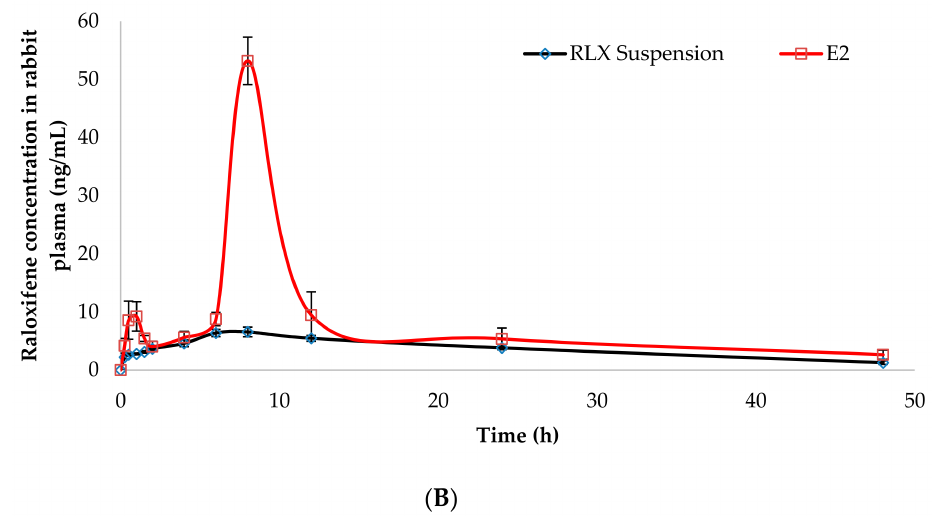
Figure 6. ( A ) Ex vivo drug permeation from RLX-loaded NFs formula (E2), in comparison to RLX aqueous dispersion, in phosphate buffer saline (pH 6.8 of 0.1% tween 80) at 37 ± 0.5 ◦ C (mean ± SD; n = 3). ( B ) RLX plasma concentration-time profiles following the buccal application of RLX-loaded nanofibers formula (E2) and the oral administration of RLX aqueous dispersion in rabbits (mean ± S.D., n =